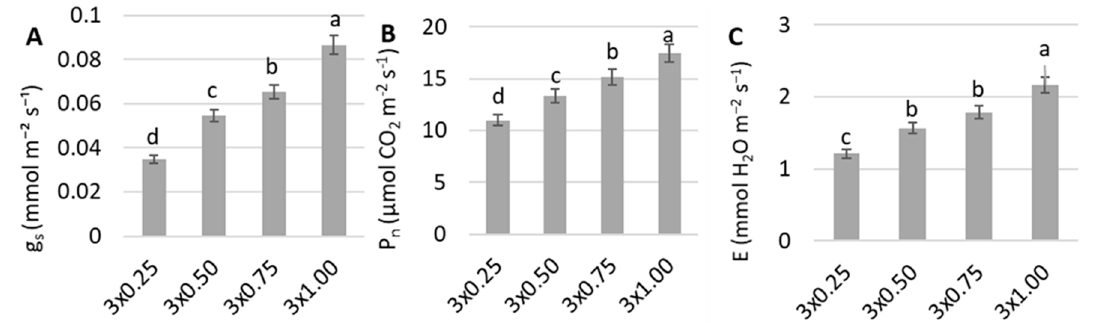
Figure 2. Effect of seasonality regardless distances between trees on the stomatal conductance g s ( A ), photosynthetic rate P n ( B ), and transpiration rate E ( C ). The different letters in graphics indicate significant differences. The data were processed using one-way analysis of variance (Anova), the Turkey (HSD) test at the confidence level p = 0.05.